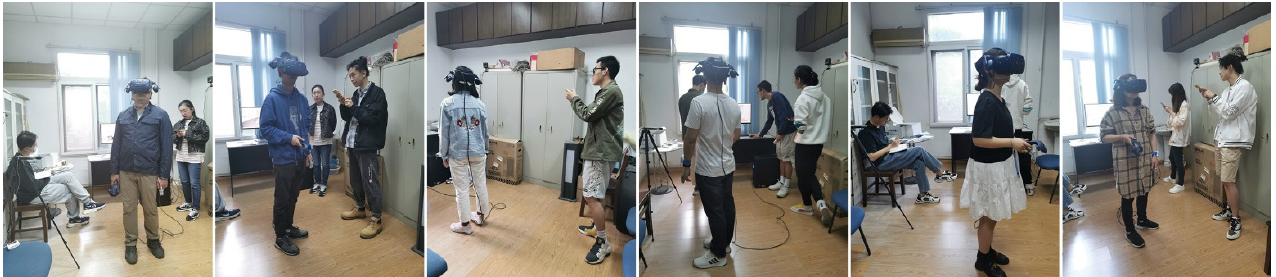
Figure 6. VR experimental scenes with six random